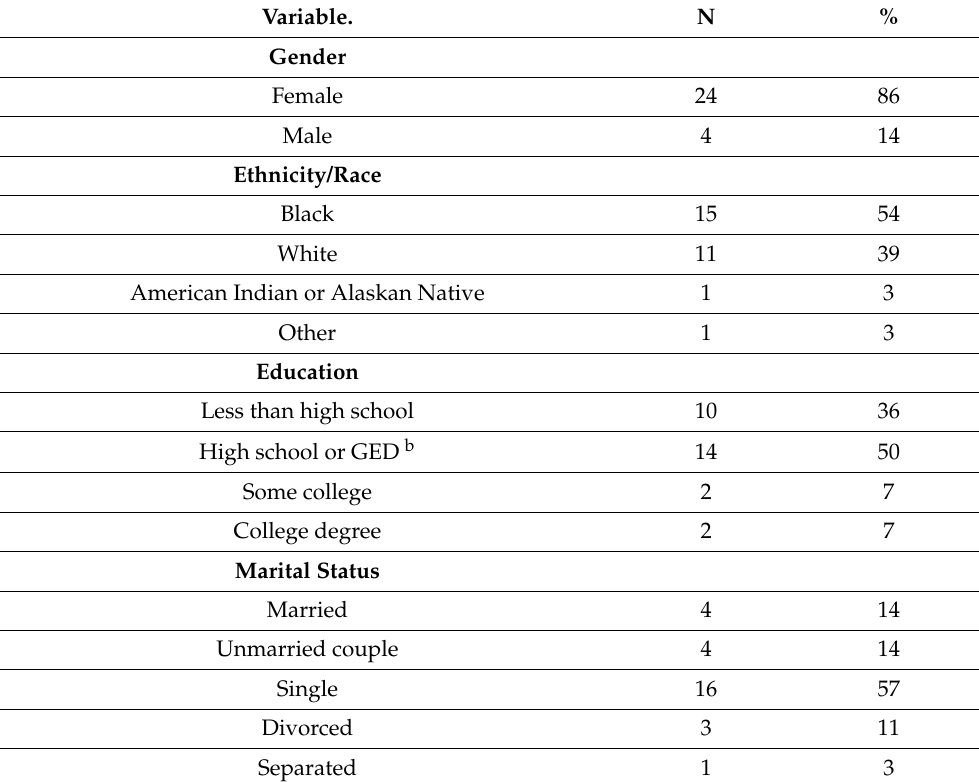
Table 1. Demographic information for FGD participants in three rural low-income Louisiana parishes, N = 28 a .